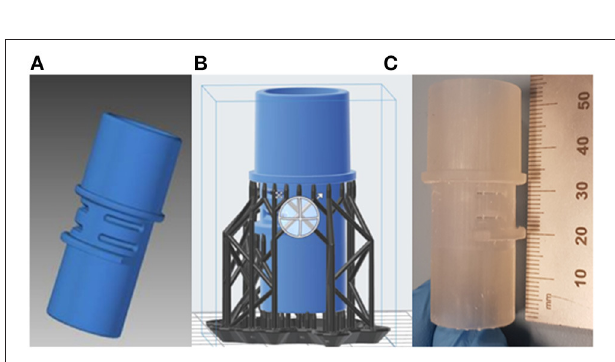
FIGURE 8 | (A) Final CAD model of the leak port; (B) Pre-processing of leak port, with support structures; (C) Printed leak